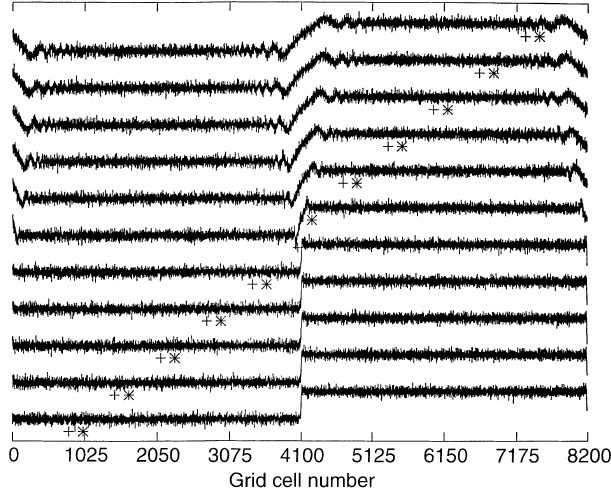
Fig. 4. The power spectrum of the time stationary, unwindowed ( upper plot ) and Hanning windowed ( lower plot ) dataset sampled by spacecraft 1 in a double logarithmic plot. The abscissa denotes the frequency in units of D f and the ordinate the power at the corresponding frequency. The zero frequency is omitted since it will not be used by